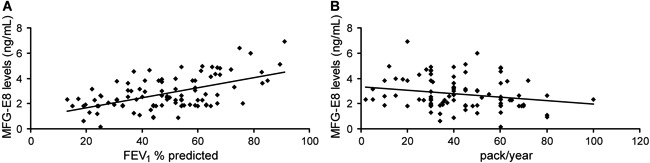
Correlation analysis between milk fat globule epidermal growth factor 8
(MFG-E8), forced expiratory volume in 1 s (FEV1) % predicted, and
smoking habit.